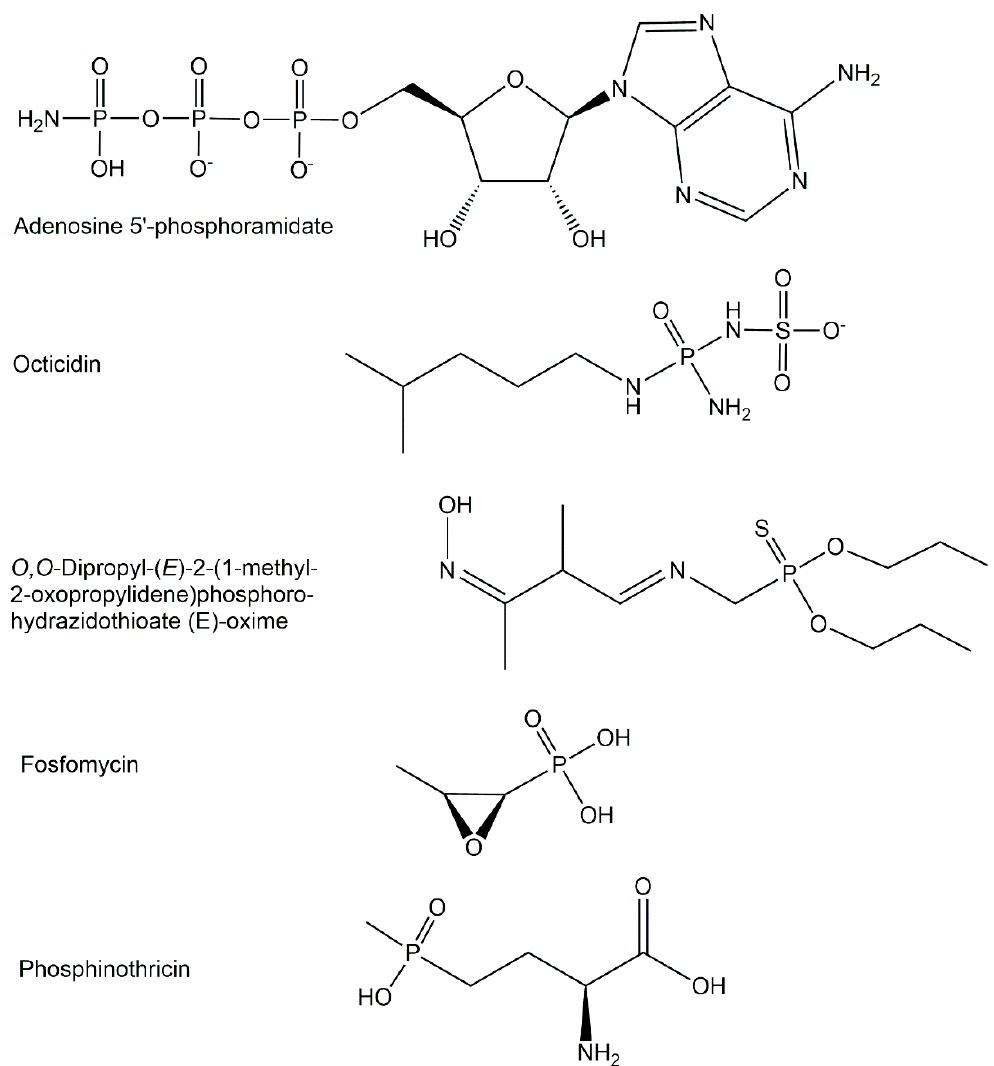
Figure 3. Selected phosphometabolite structures containing P-N- bonds, P-S- bonds, and P-C-